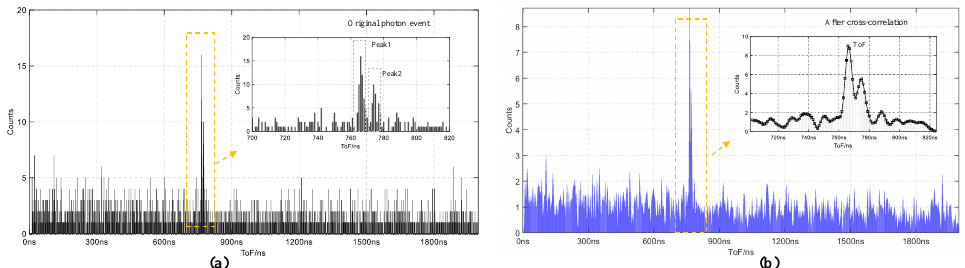
Figure 6. Depth extraction process used in LiDAR transceiver. ( a ) cumulative histogram of individual beams: horizontal axis represents the photon time-of-fight (ns) relative to the strobe gate; vertical axis shows the photon count at each bin; ( b ) photon sequence after cross-correlation. The inner diagram represents the curve between 700 and 820 ns with the target at the peak